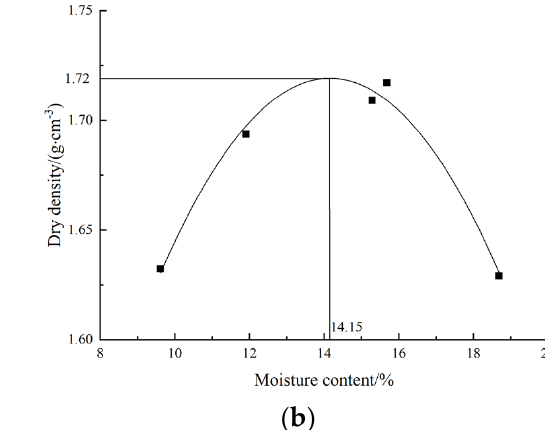
Figure 4. Physical property curve of Xining loess. ( a ) Grain size distribution of Xining loess; ( b ) compaction curve of Xining loess.